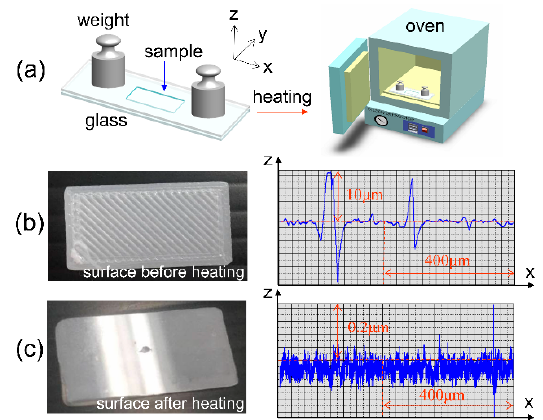
Figure 6. Surface modification of a 3D printed structure of polylactic acid (PLA) material: ( a ) Thermal treatment within a vacuum oven, and 2D profiling of the PLA specimen with a roughness R a = 1.12 µ m before treatment in ( b ) and R a = 0.023 µ m after treatment in ( c ).